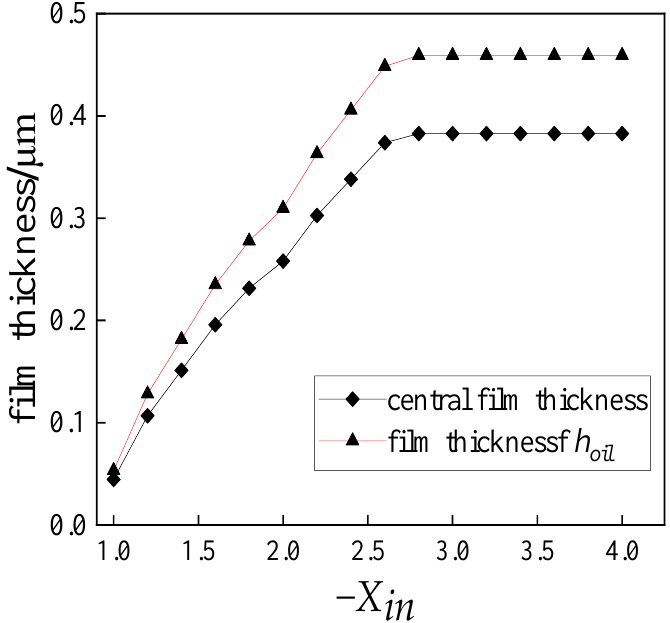
Figure 8. Relationship between film thickness h oil and inlet position − X in .